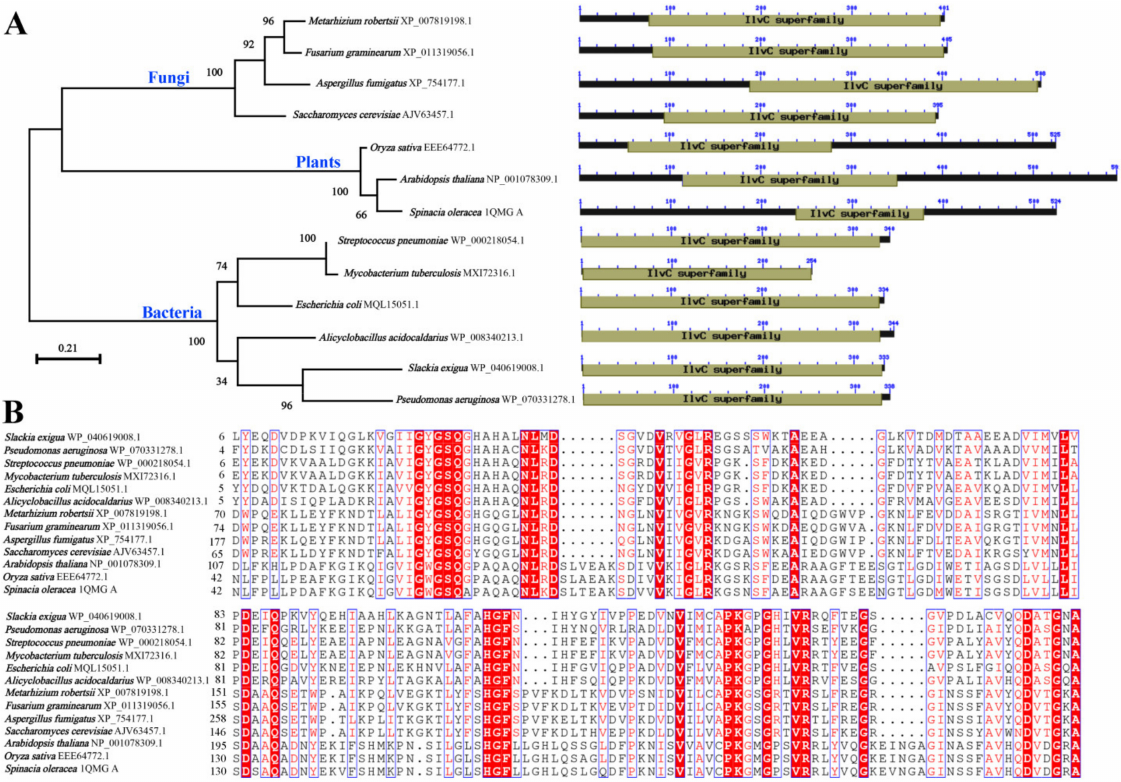
Figure 1. ILVCs in diverse organisms. ( A ) Phylogenetic analysis of ILVCs. ( B ) Conserved domain arrangements of the ILVCs.